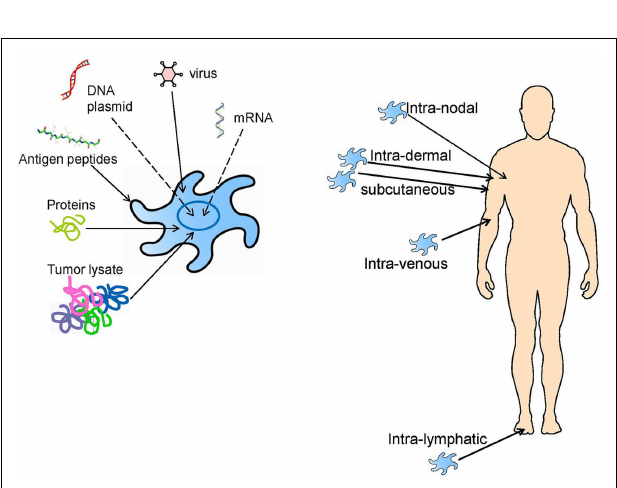
FIGURE 2 | DC vaccine loading and administration approaches that have previously been tested in clinical trials, and which are still being investigated today